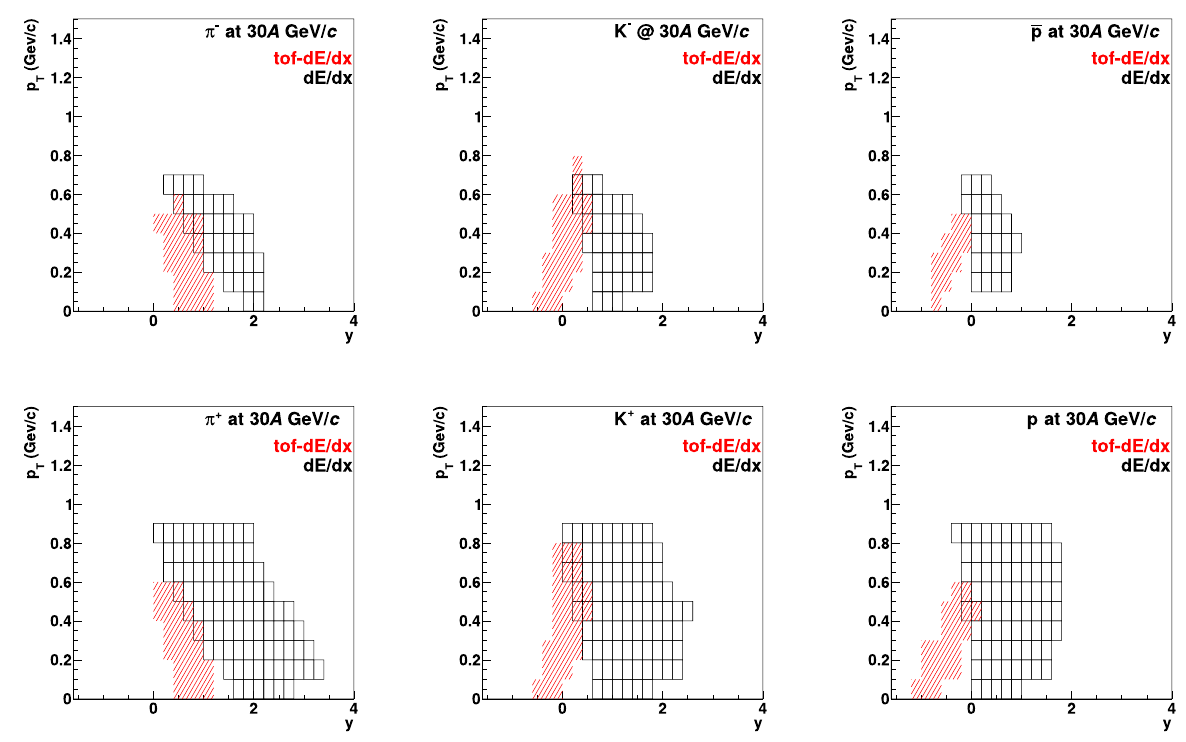
Fig. 5 Acceptanceofthe tof -d E / d x andd E / d x methods for identificationof pions, kaons andprotons inthe 20% most central Be+Beinteractions at 30 A GeV /